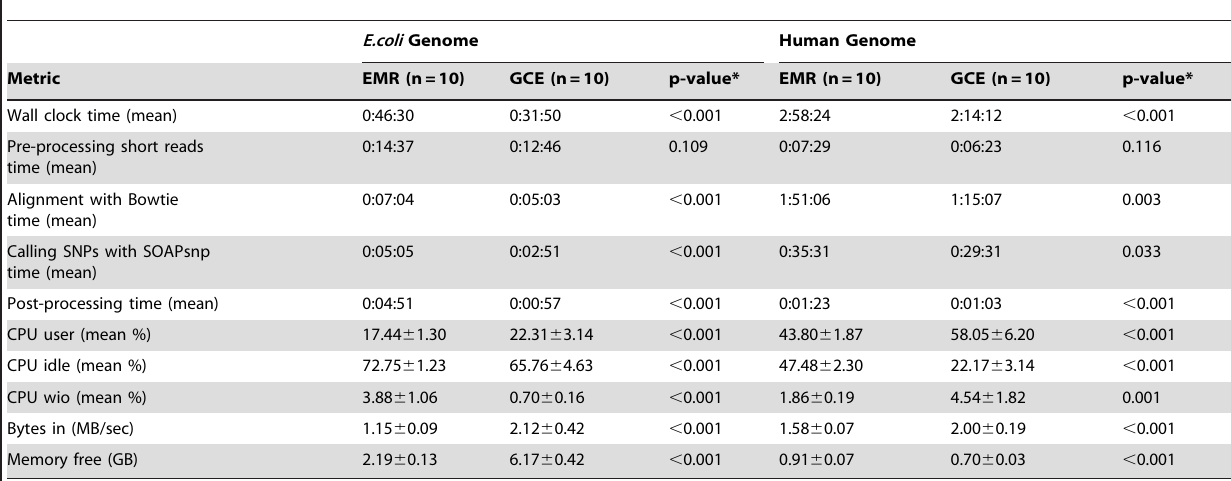
Table 1. Comparison of performance metrics for genomic alignment and SNP calling.